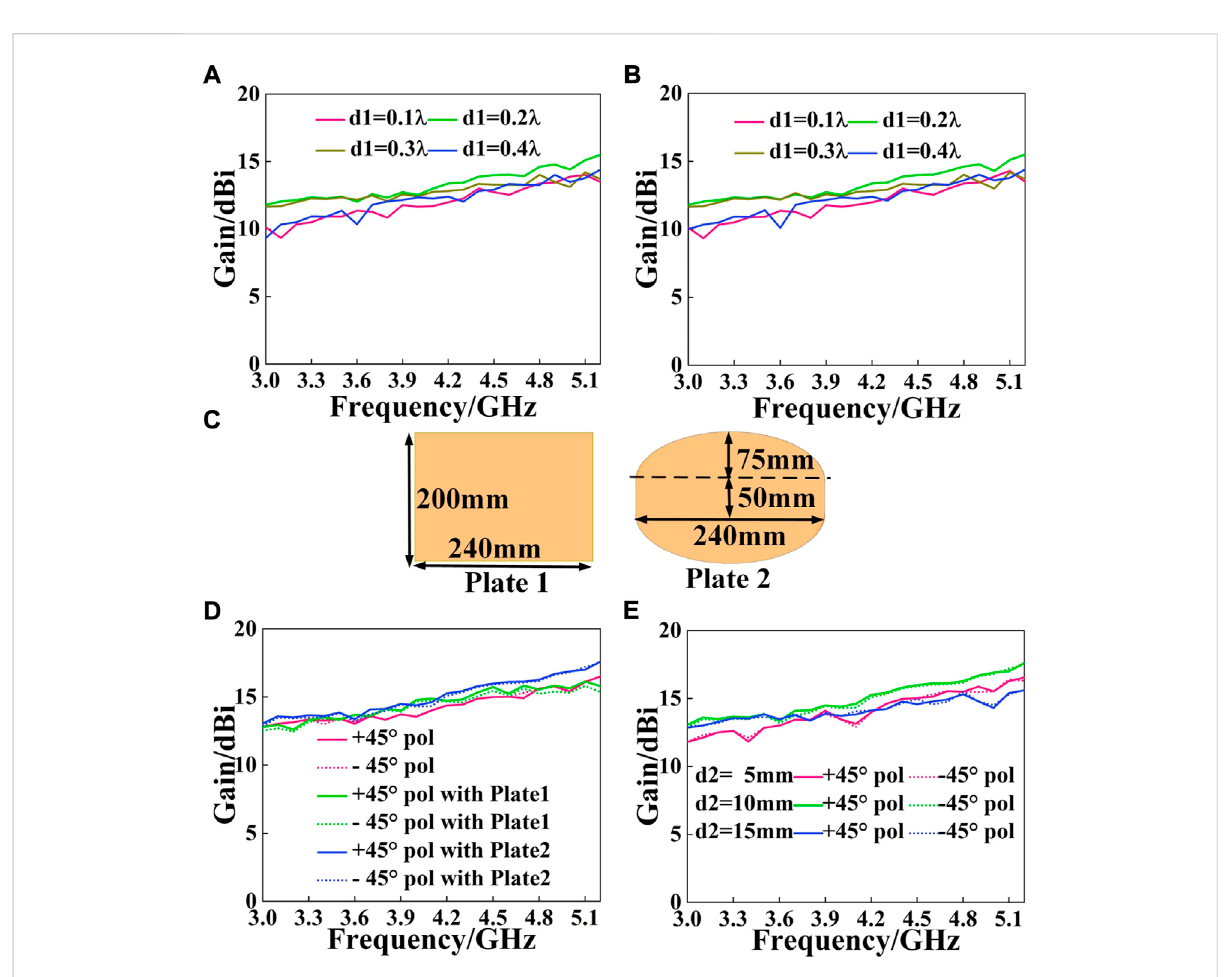
FIGURE 4 Gainperformance oftheproposed Luneburg lensantenna. (A) Gainfor+45 ° polwith different d1 . (B) Gainfor-45 ° polwithdifferent d1 . (C) Two type of plates. (D) Gain with two plates. (E) Gain with different d2